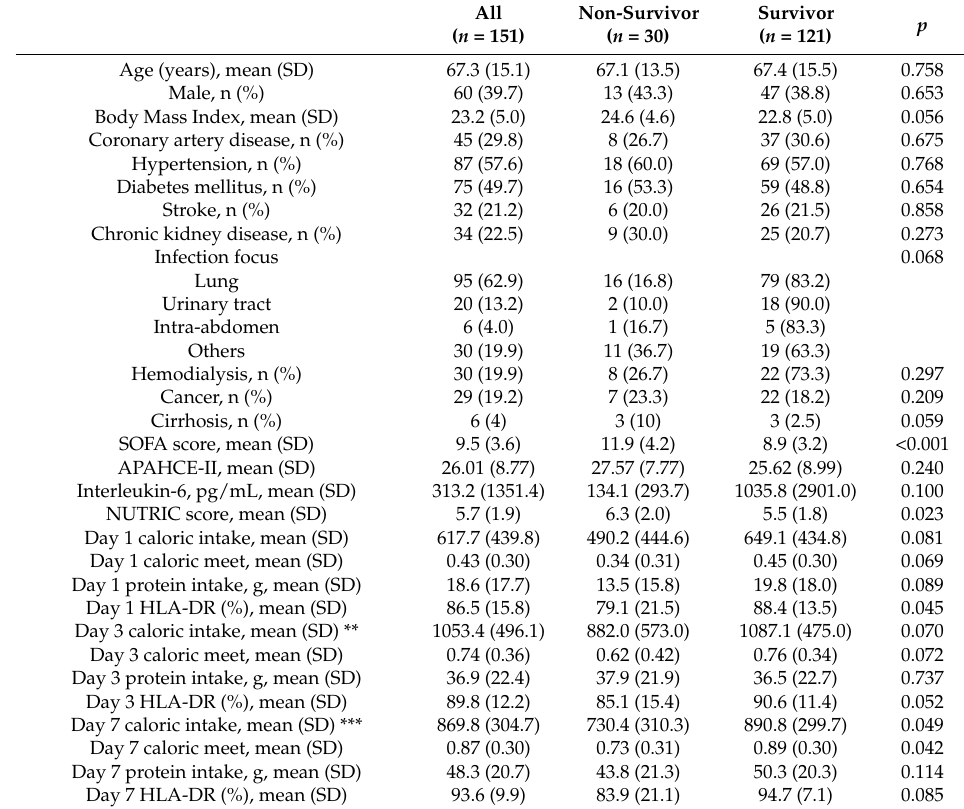
Table 1. Clinical characteristics and immune status between 28-day survivors and non-survivors. ( n = 151) *.